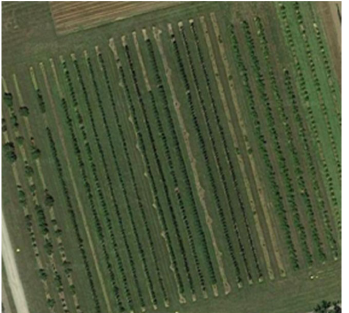
Figure 2. Birds ‐ eye view of the apple orchard used in the study. Figure 2. Birds-eye view of the apple orchard used in the study.